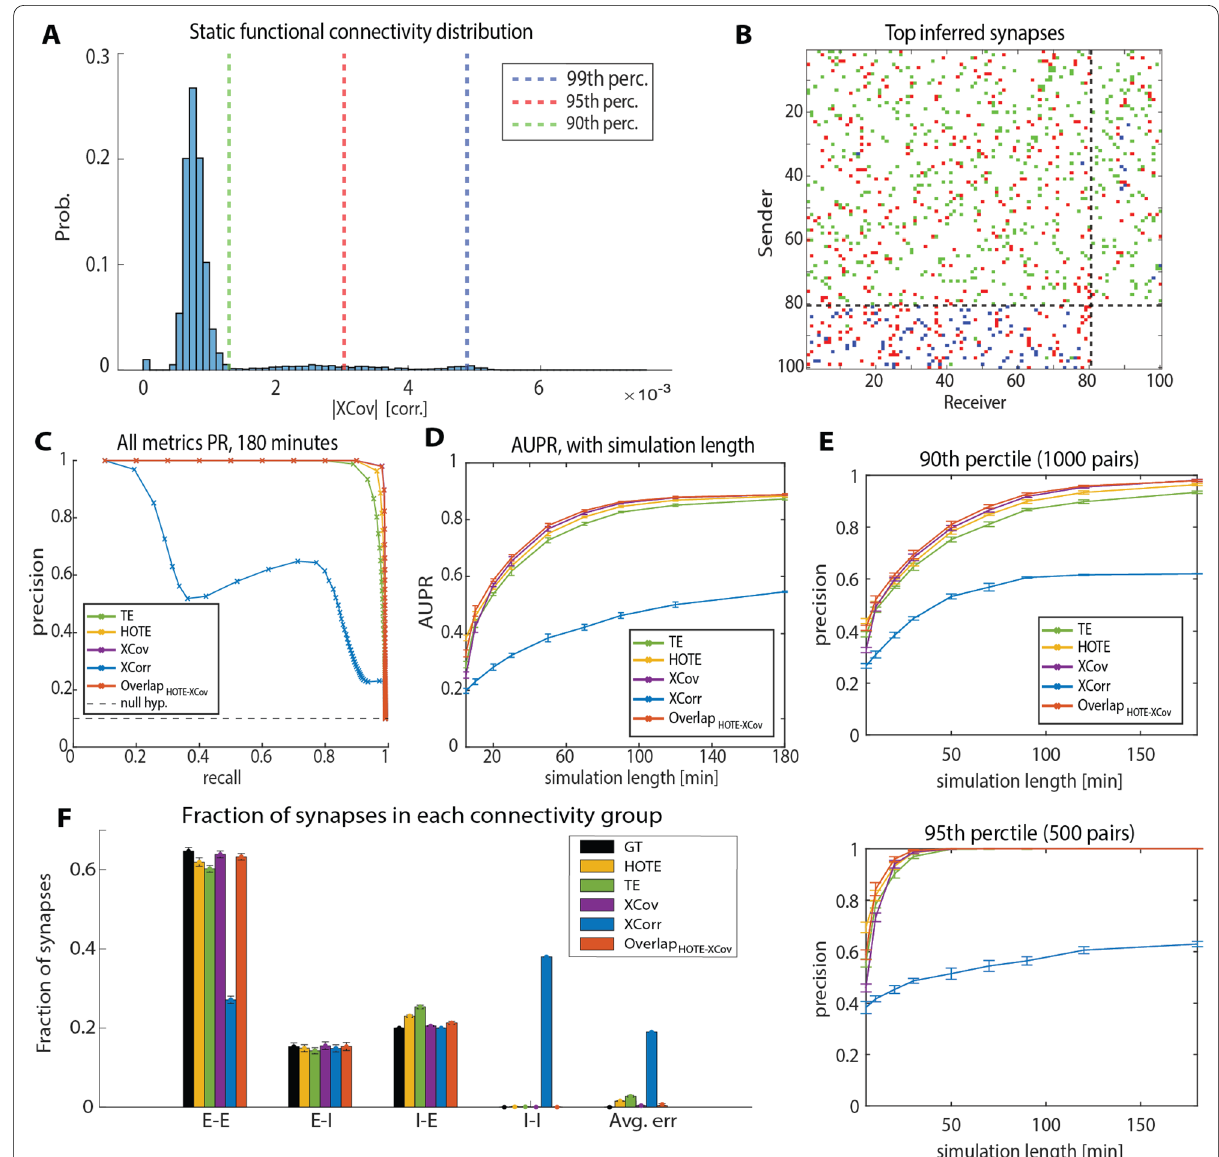
Fig. 3 Performance of static FC measures in inferring the presence of synapses. A Example distribution of static FC values measured using XCov. The 90th, 95th and 99th percentile were highlighted by dashed vertical lines (in green, red and blue, respectively). B Connectivity matrix obtained by considering only synaptic weights above a given percentile of the static FC distribution. The color of synapses represents the percentile (matched with panel A) for which they were included in the connectivity matrix. C Precision–recall (PR) curves computed from 180 min of simulated activity for TE, HOTE, XCov and XCorr. Each point is one percentile of the distribution of static FC values across pairs, going from the 1st (bottom right) to the 99th (top left) percentile. D AUPR trend with simulation length (length ranges from 5 to 180 min). E Comparison of precision in identifying connected pairs with simulation lengths, with a 90th (1000 pairs) and 95th (500 pairs) percentile threshold on the static FC distributions. F Fraction of pairs belonging to each group of synapses, from 180 min simulation and with a 90th percentile threshold on the FC distributions GT denotes ground truth. All error bars in the figure are SEM across repetitions of the simulation ( N =